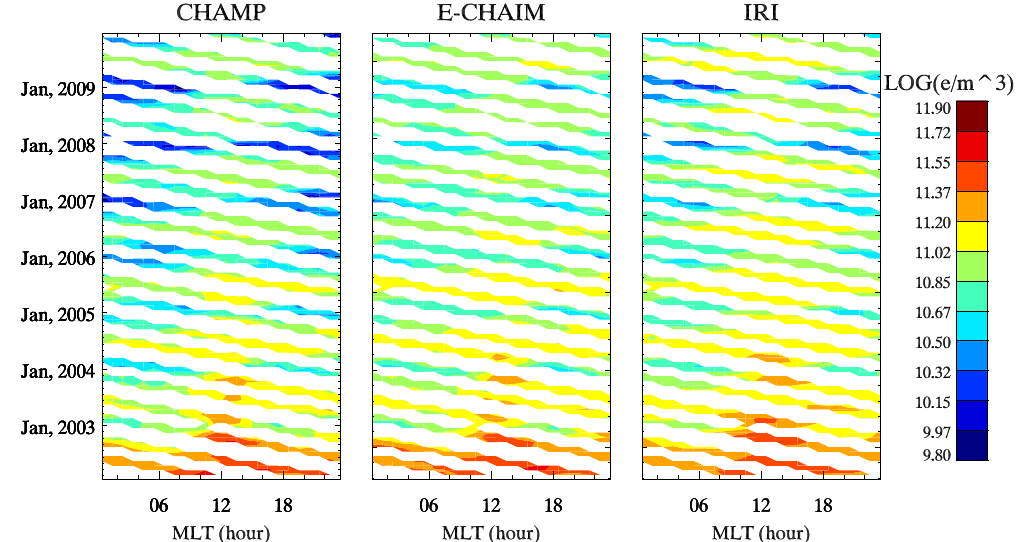
Fig. 15. Log contours of CHAMP (left), E-CHAIM (center), and IRI (right) monthly median electron density at CHAMP orbit altitude from a bin between 65 (cid:1) N and 75 (cid:1) N.